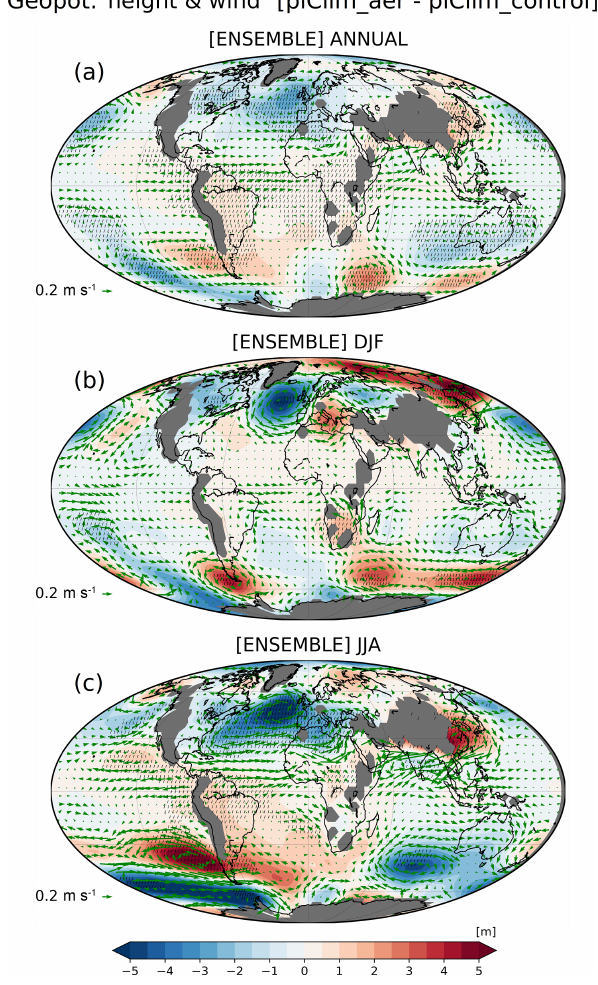
Figure 9. Differences between piClim-aer and piClim-control in geopotential height (m) and wind vectors at the 850hPa pressure level for the ensemble of 10 models (a) on an annual basis, (b) for DJF and (c) for JJA. The dot shading indicates areas in which the differences are statistically significant at the 95% confidence